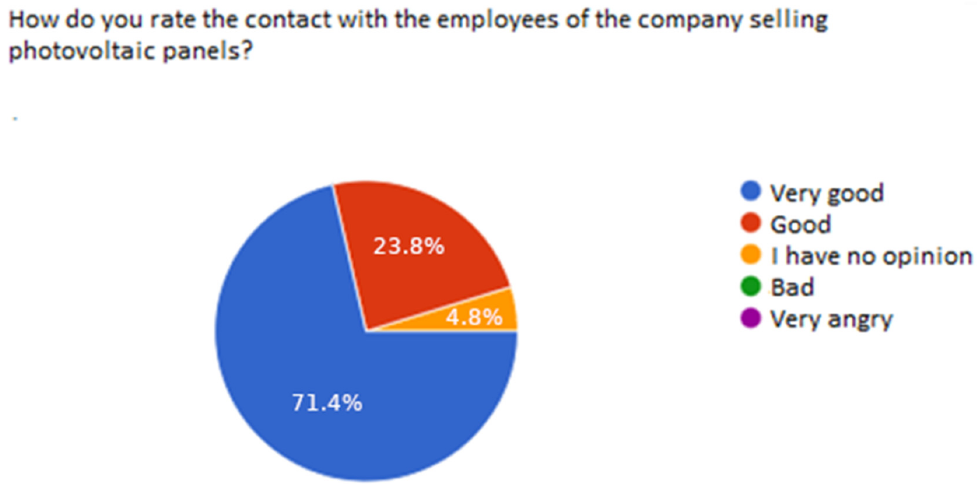
Figure 18. Elements influencing the choice of service provider.